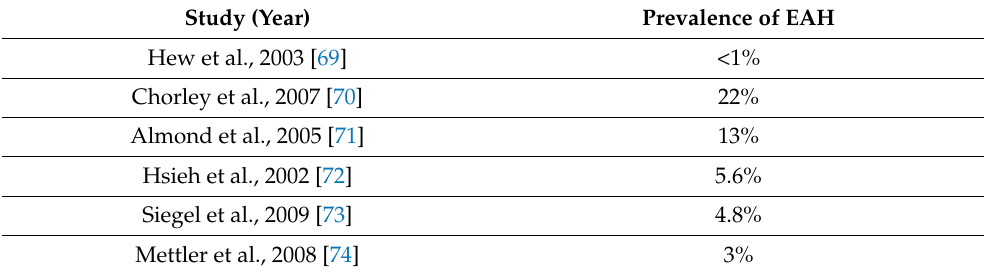
Table 2. Prevalence of exercise-induced hyponatremia (EAH) in marathon